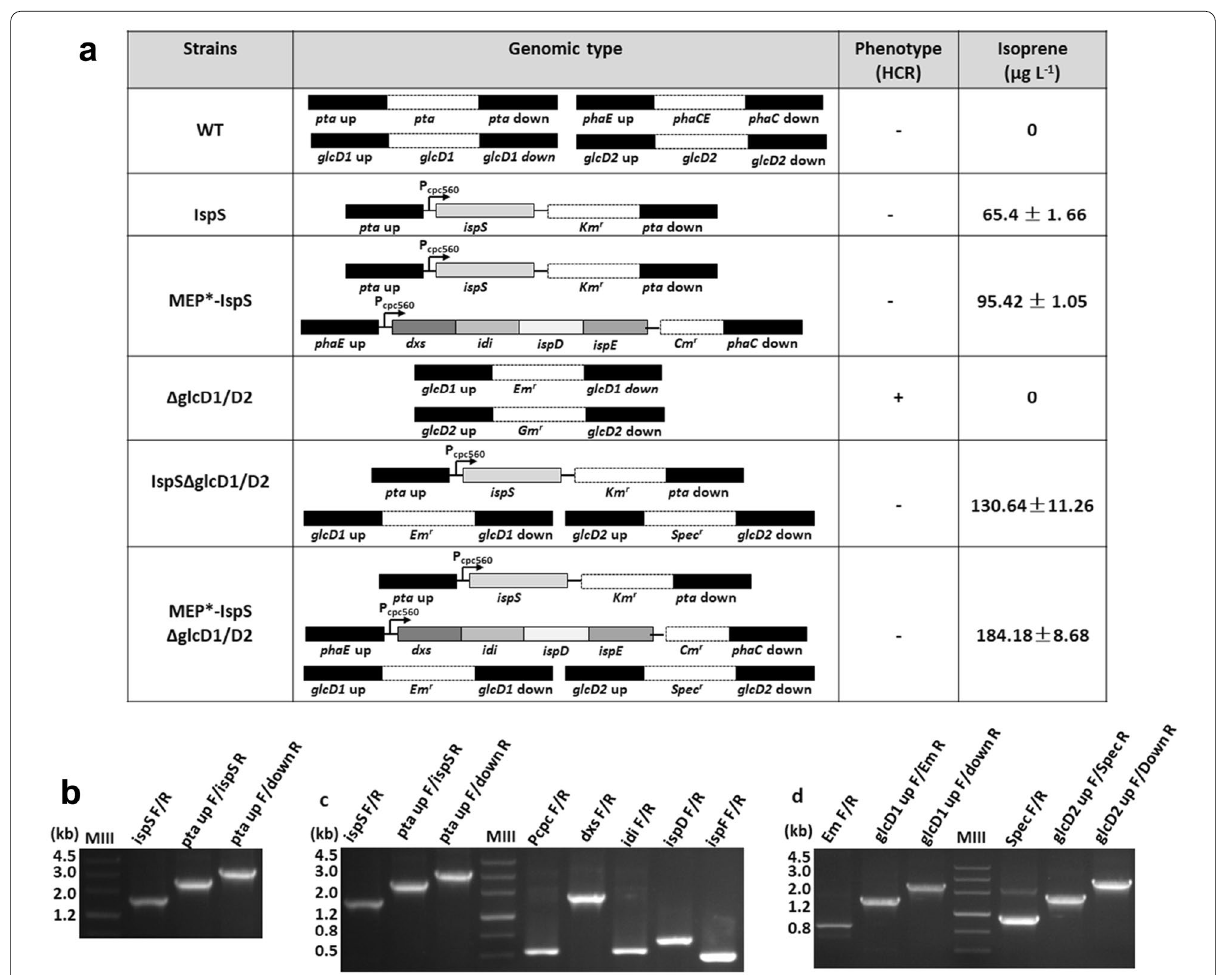
Fig. 2 Construction of mutant strains. a Genetic modifications to impair photorespiration and introduce the isoprene synthetic pathway. b Whole-cell PCR for the recombinant cassette harboring the ispS gene at the pta site; one primer was set 100 bp external to the recombinant cassette, which demonstrated the complete segregation of the Isps mutant. c Whole-cell PCR with specific primers demonstrating the integration of each gene into the chromosome of the recombinant strain MEP*-IspS. d Whole-cell PCR with specific primers for complete segregation of knocking out glcD1 and glcD2 gens in photorespiration impairing mutantsΔglcD1/D2, IspSΔglcD1/D2 and